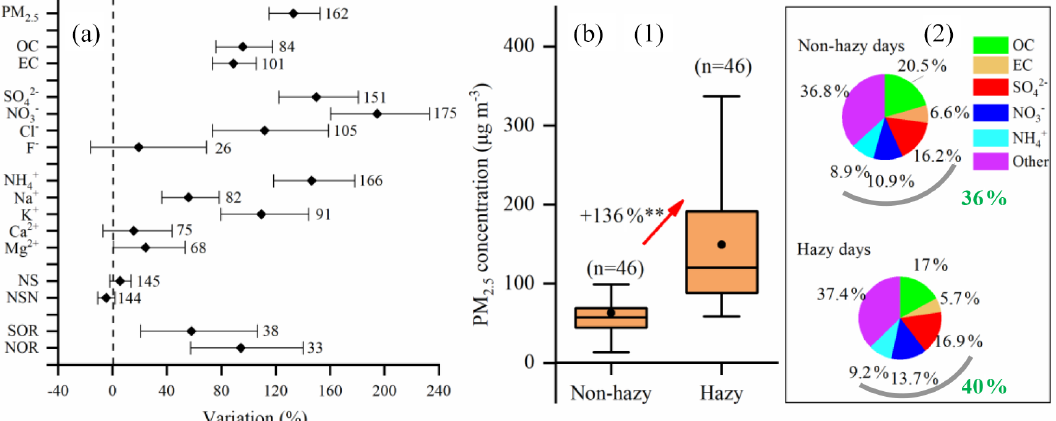
Figure 4. (a) Variations in PM 2 . 5 concentration, aerosol component concentration, NS, NSN, SOR, and NOR from non-hazy to hazy days in China during 2000–2019. (b) Subpanel (1) Summary of differences in PM 2 . 5 concentration between non-hazy and hazy days in China; (2) the average proportions of components of PM 2 . 5 on non-hazy and hazy days. NS is the slope of the regression equation between [NH + ] 4 + NO − and [SO 2 − ], NSN is the slope of the regression equation between [NH + ] and [SO 2 − ], SOR is sulfur oxidation ratio, and NOR 4 4 4 3 is nitrogen oxidation ratio. The variations are considered significant if the confidence intervals of the effect size do not overlap with zero. ∗∗ denotes significant difference ( P < 0 . 01) between hazy days and non-hazy days. The upper and lower boundaries of the boxes represent the 75th and 25th percentiles; the line within the box represents the median value; the whiskers above and below the boxes represent the 90th and 10th percentiles; the point within the box represents the mean value. Values adjacent to each confidence interval indicate number of measurement sites. The n represents independent sites; more details on this are presented in Sect.